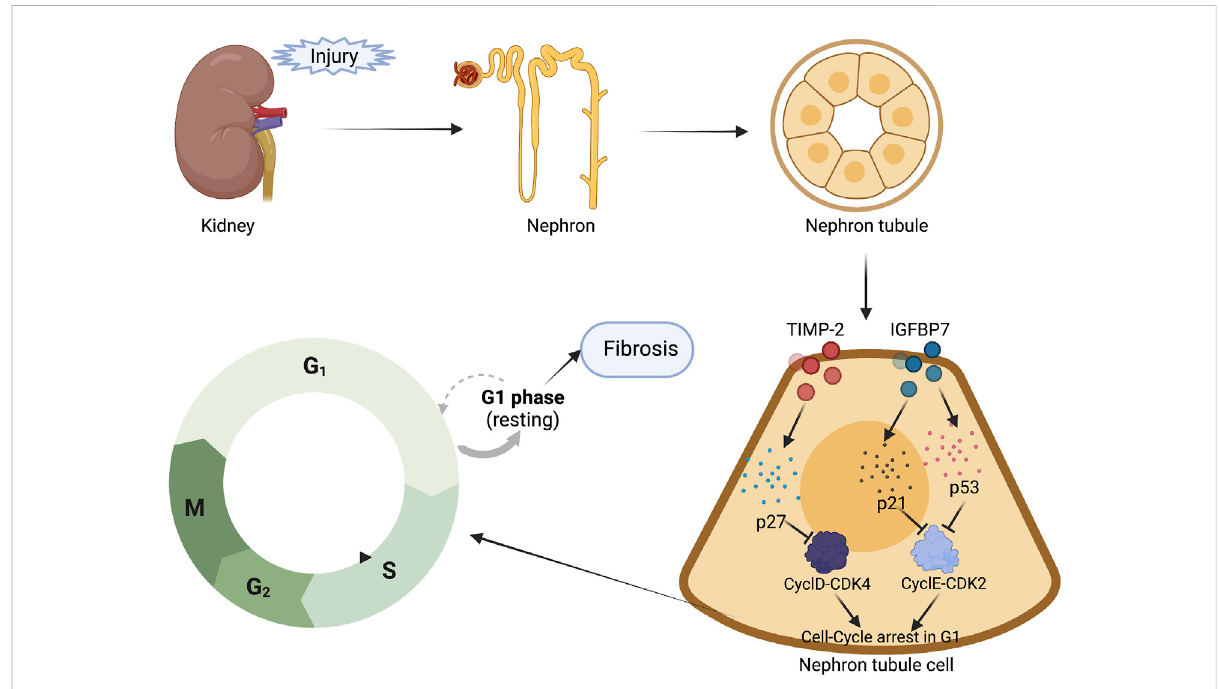
FIGURE 2 G1 Cell cycle arrest markers: TIMP-2 and IGFBP7(Created with